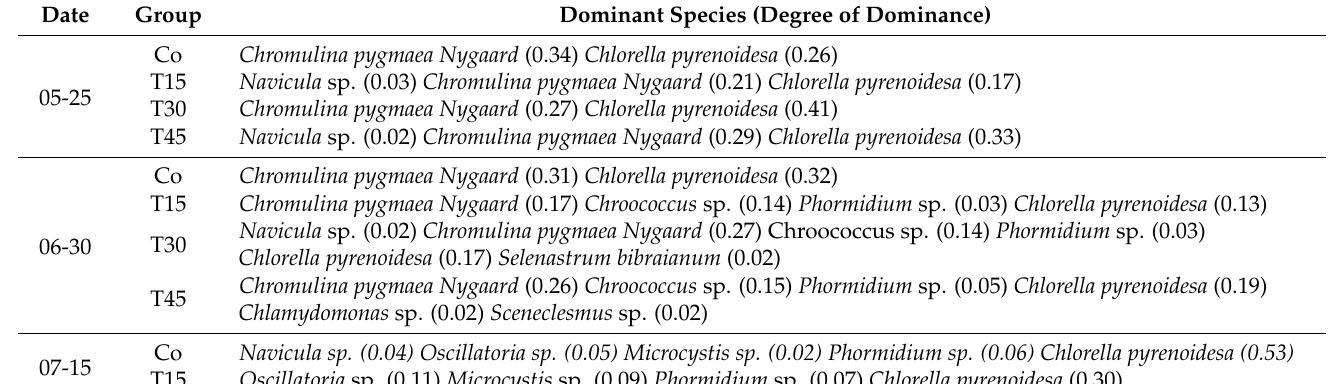
Table A5. Composition of the predominant species of phytoplankton in the enclosures of each treatment group ( n =